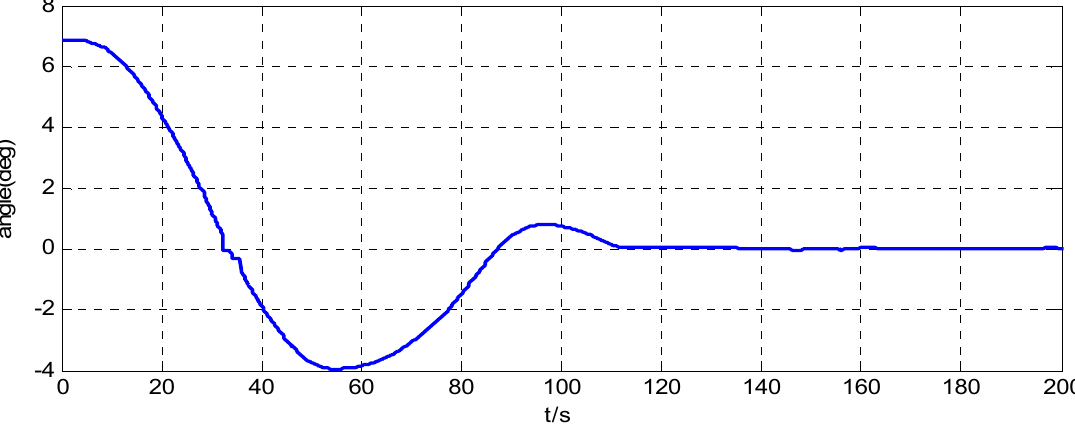
Figure 6. Angle around the z-axis of the simulator when θ z ( 0 ) = 6.85 ◦ .